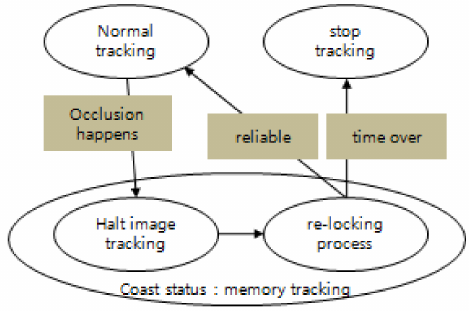
Figure 2. State diagram of the coast mode tracking